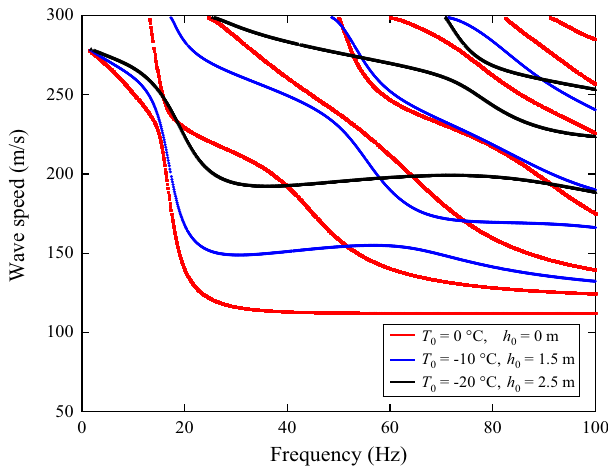
Figure 11. Dispersion curves of the frozen and non-frozen